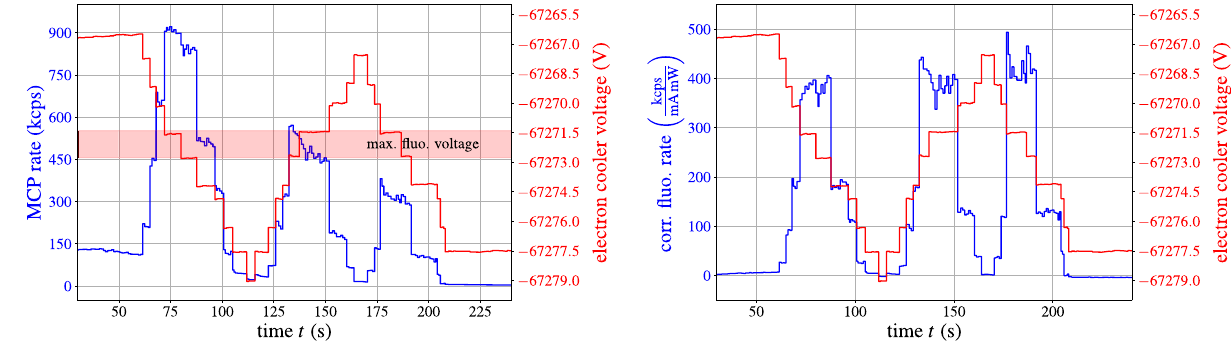
Figure 5. Left: raw detector rates (blue curve) for a scan of the electron cooler voltage (red curve) over 2 S 2 P the resonance region of the 1 / 2 − 3 / 2 transition. Right: fluorescence rates of the same voltage scan after background subtraction, normalization to ion current and laser power and MCP gain